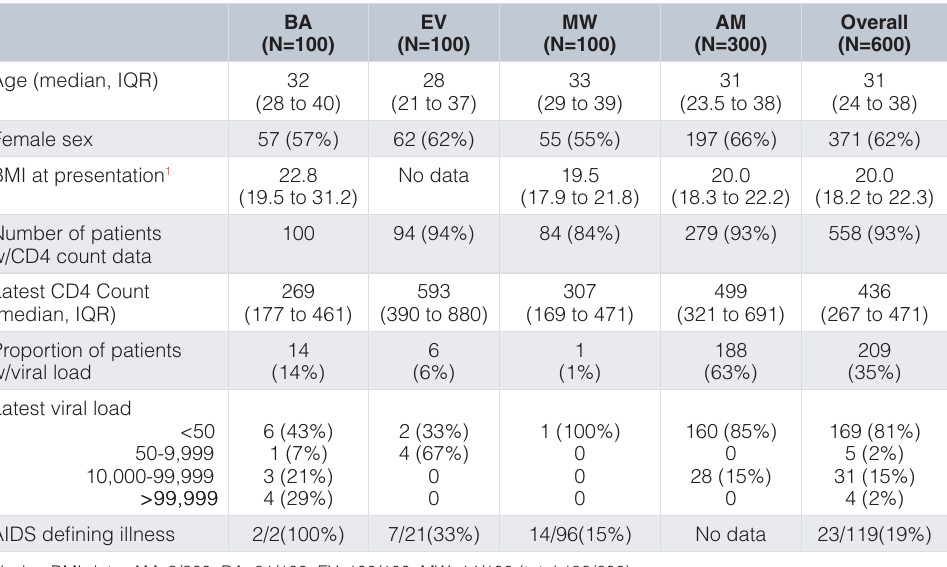
Table 2. Patient characteristics.